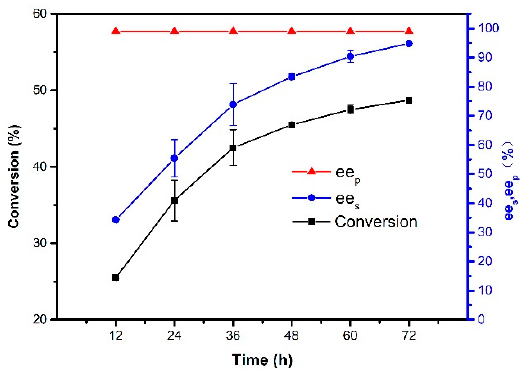
Figure 10. Effect of reaction time on the resolution of 1-phenylethanol. Reactions performed with 5 mg magnetic CALB CLEAs and 2 mL of n-hexane containing 0.2 mmol of 1-phenylethanol and 0.4 mmol of vinyl acetate at 50 °C.